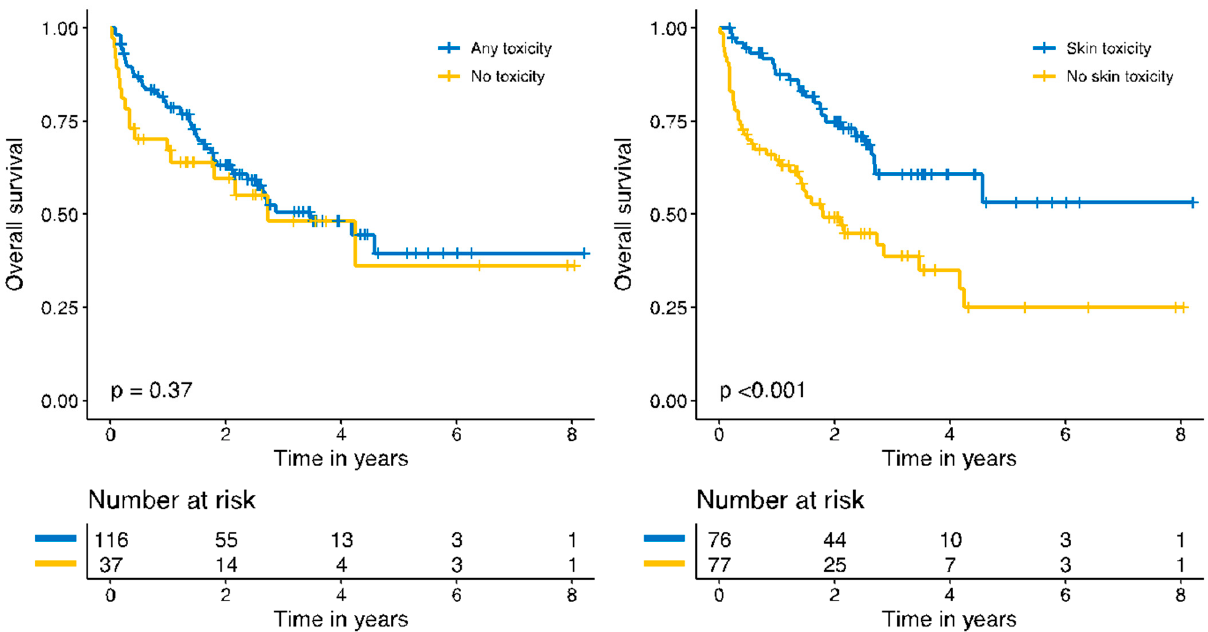
Figure 3. Kaplan–Meier plots for overall survival. A multivariate analysis of the benefit of experiencing derm irAEs in overall survival, after adjusting the model for the AJCC stages and for the duration of the therapy, demon- strated that this survival advantage was no longer statistically significant (HR 0.74, 0.44– 1.25, p = 0.263) (Table 2). Table 2. Univariate and multivariate analyses of overall survival.